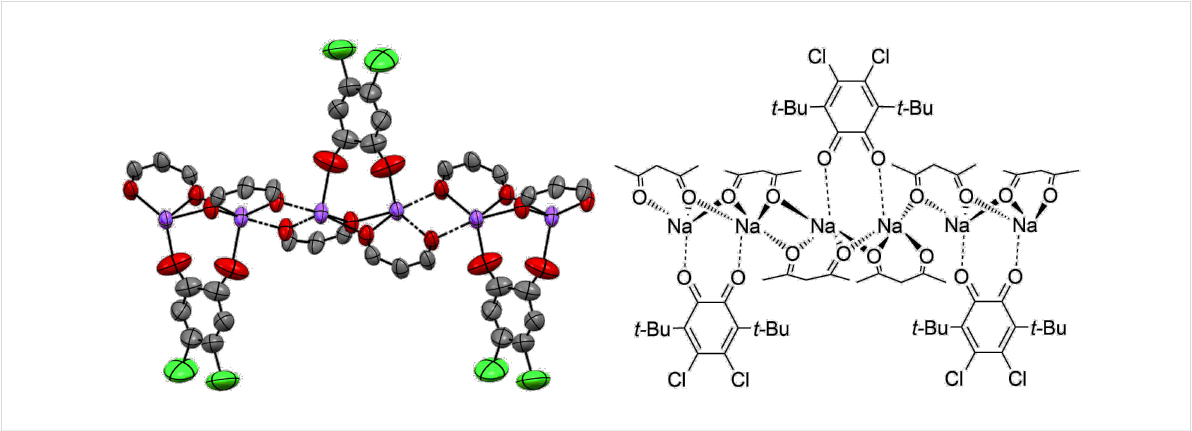
Figure 2: Fragment of coordination polymer chain of adduct 8 in the crystal phase. Hydrogen atoms and CF 3 groups are omitted for clarity.